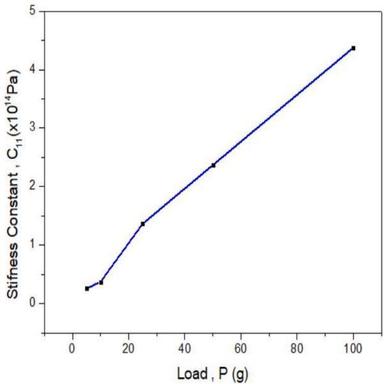
Graph exhibiting the relation between stiffness constant and load - G4C3NBM.